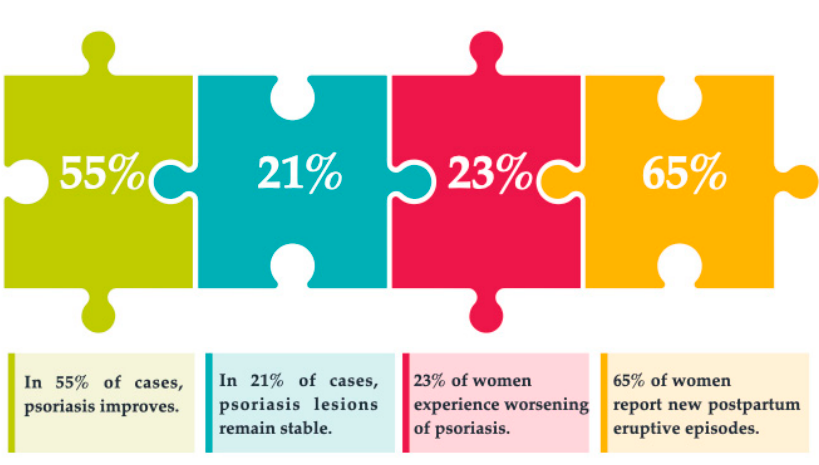
Figure 3. Psoriasis during pregnancy